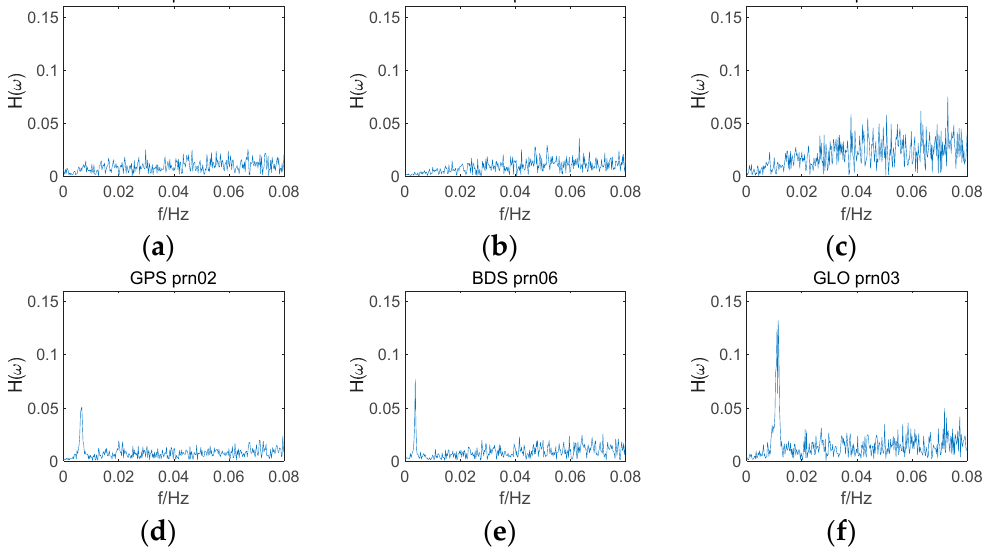
Figure 8. Comparison of the GNSS satellites’ frequency spectra, ( a ) G17, ( b ) C01, ( c ) R05, ( d ) G02, ( e ) C06, ( f ) R03.